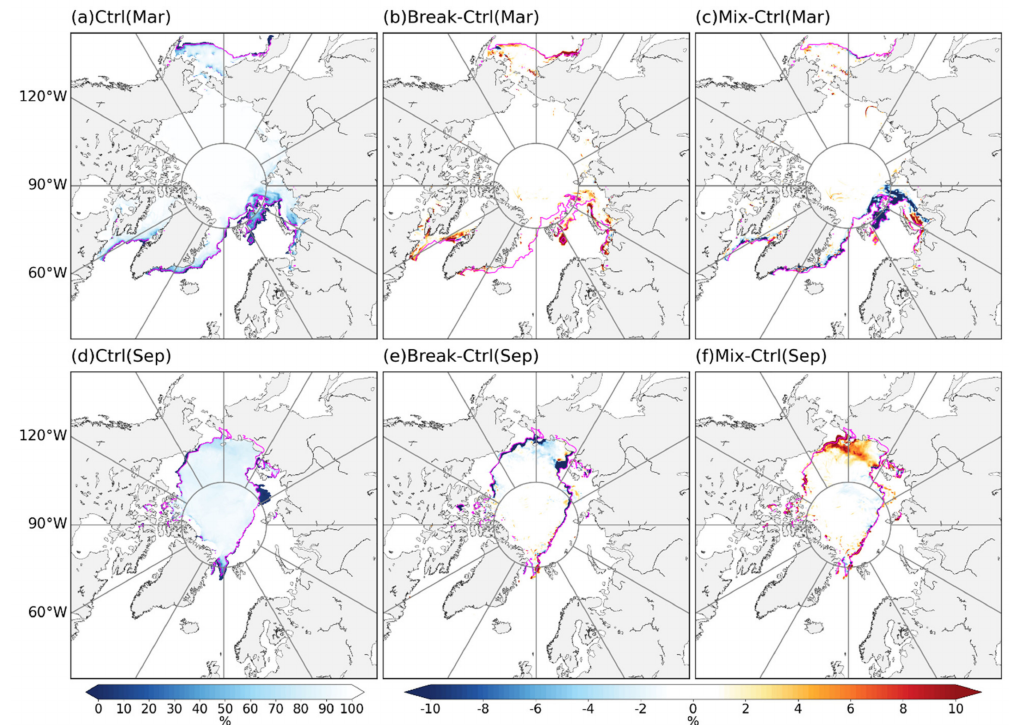
Figure 3. Sea ice concentration from the control run ( a ) in March, the differences between Break and Ctrl ( b ), and the differences between Mix and Ctrl ( c ). ( d – f ) Same as ( a – c ), but for September. The magenta line in ( a – c ) and ( d – f ) indicate the ice edge (sea ice concentration of 15%) for March and September in the Ctrl experiment,